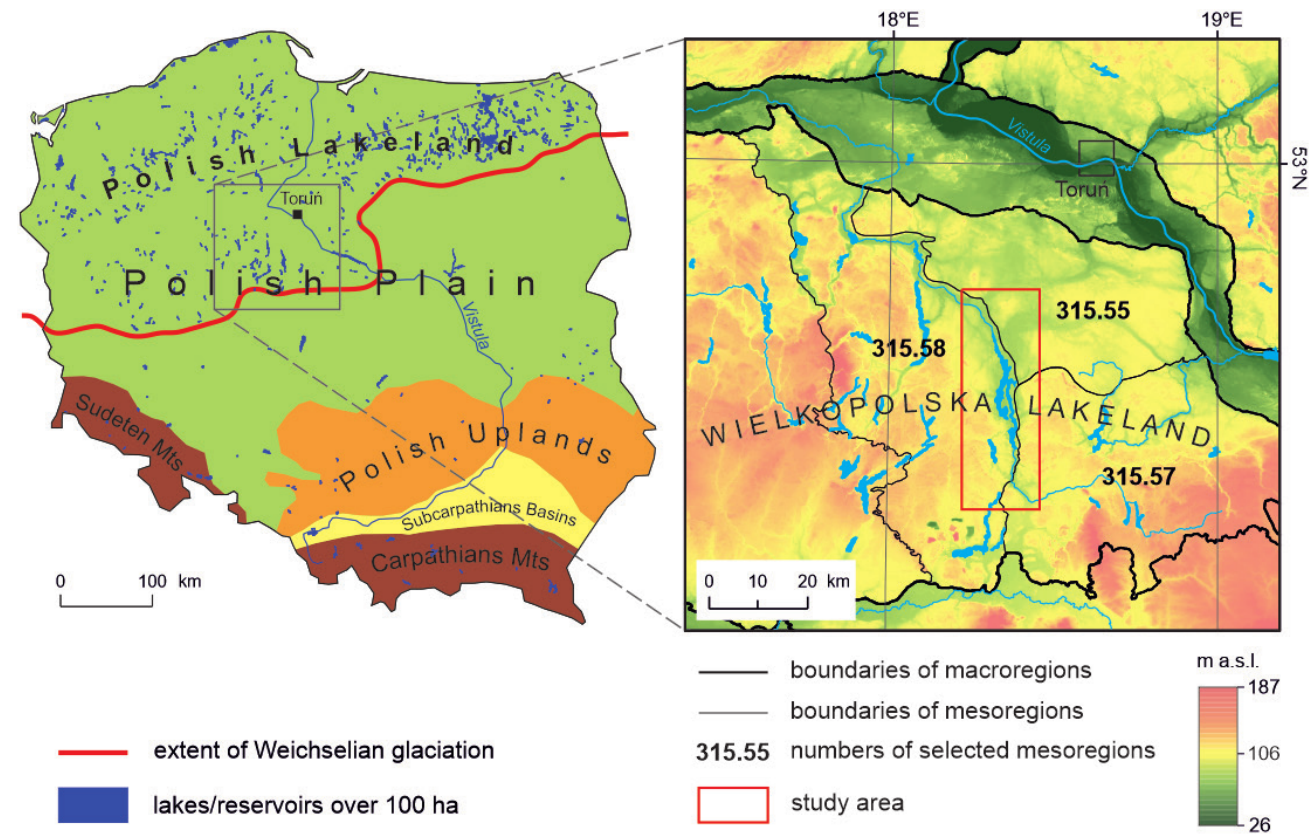
Figure 2. The distribution of lakes in Poland and location of research area against the background of the Żnin-Mogilno Lakeland, Inowrocław Plain and Kujawy Lakeland mesoregions (315.58, 315.55 and 315.57, respectively) (Kot 2016; Solon et al.,